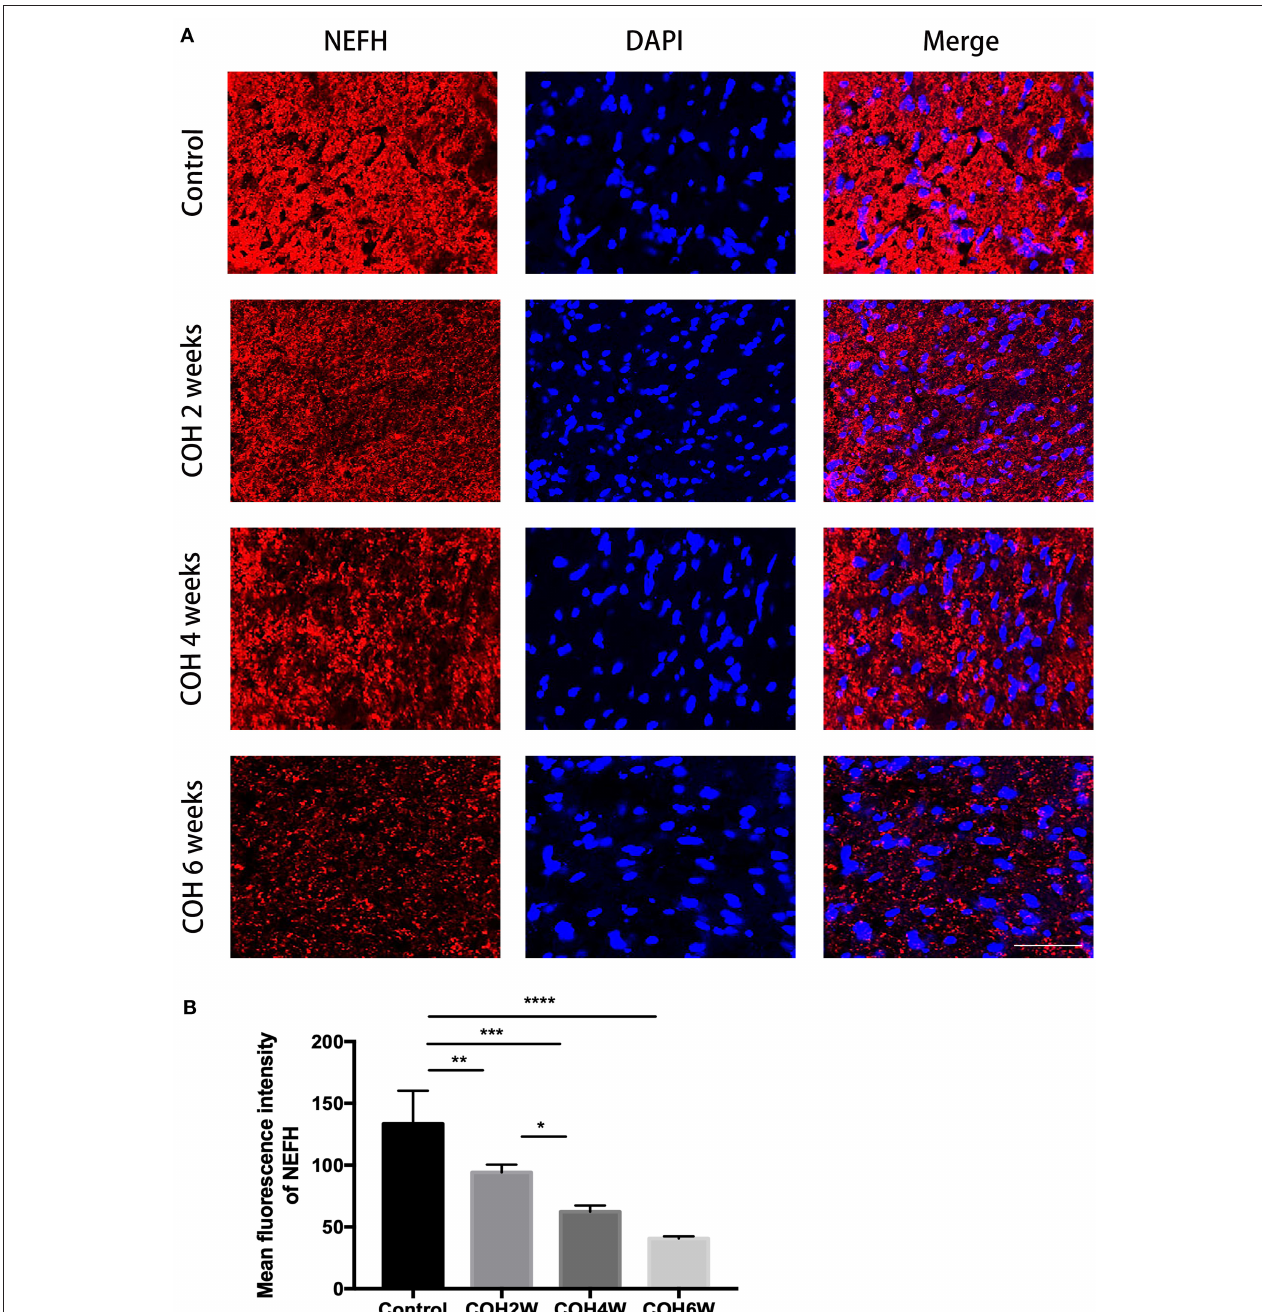
FIGURE 10 | Quantitative analysis of axon loss after COH. (A) Optic nerve slices were stained with NEFH (red fluorescence) and cell nuclei were marked with DAPI (blue fluorescence) (magnification × 200, scale bar = 50 µ m). (B) Quantitative analysis of mean fluorescence intensity of NEFH in the control group and the COH mice. COH mice showed a significant decrease of NEFH compared with the control group. Data were analyzed using one-way ANOVA followed by Tukey’s post hoc test (* p < 0.05, ** p < 0.01, *** p < 0.001, and **** p < 0.0001). N = 12 mice (control group: 3 mice; hydrogel injection group: 9 mice). Bars represent mean ± SD. NEFH, neurofilament heavy